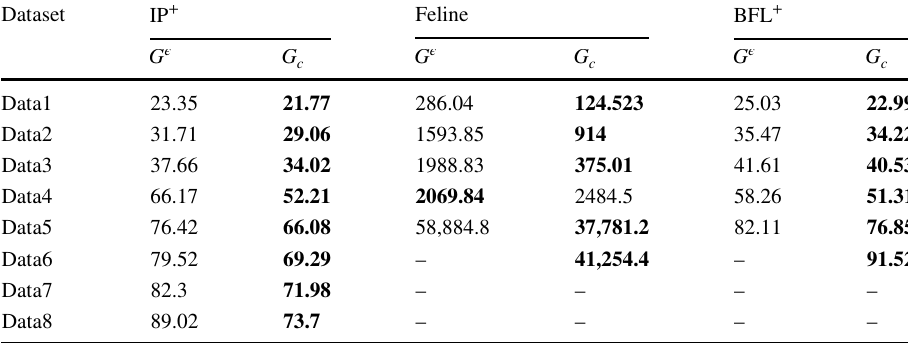
Table 9 Query time (ms) for synthetic